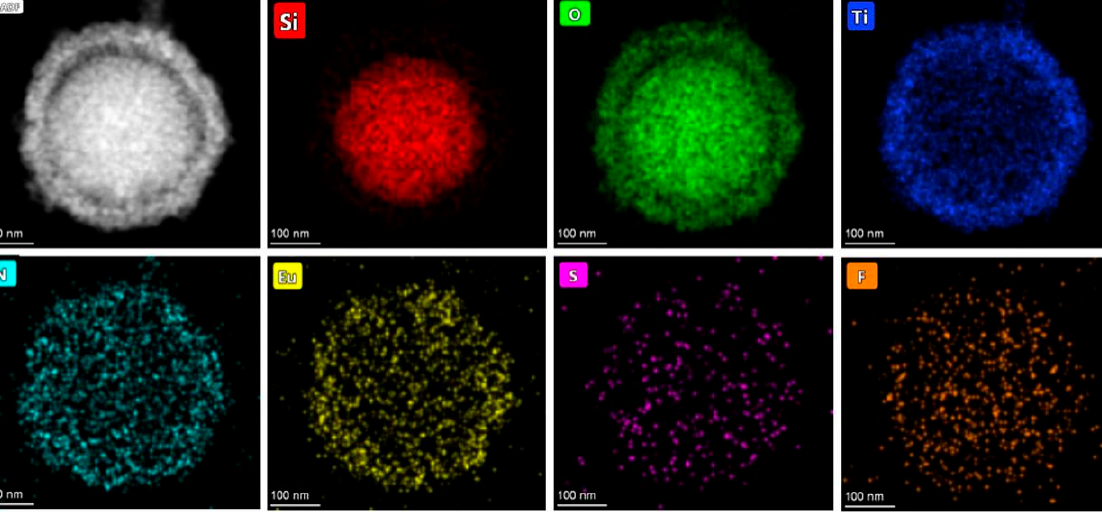
3 bpdc-SiO 2 @mTiO 2